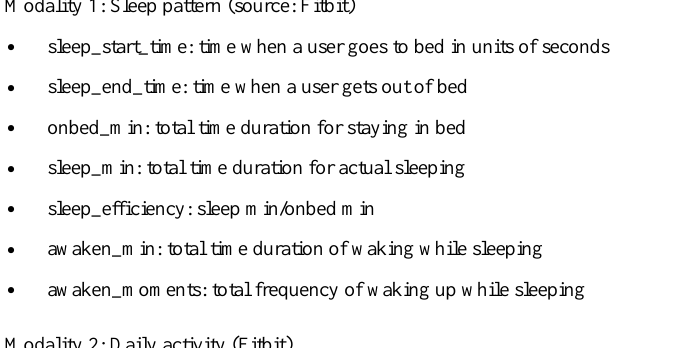
Textbox 1. List of data gathered from the smart band–wearing experiment.